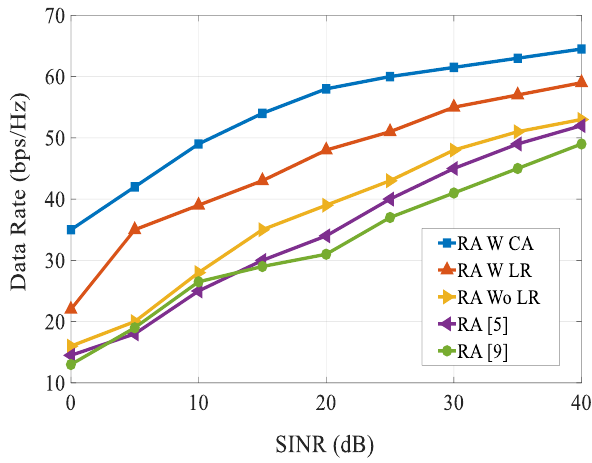
Figure 4. Data rate vs. signal-to-interference-plus-noise ratio (SINR) performance.